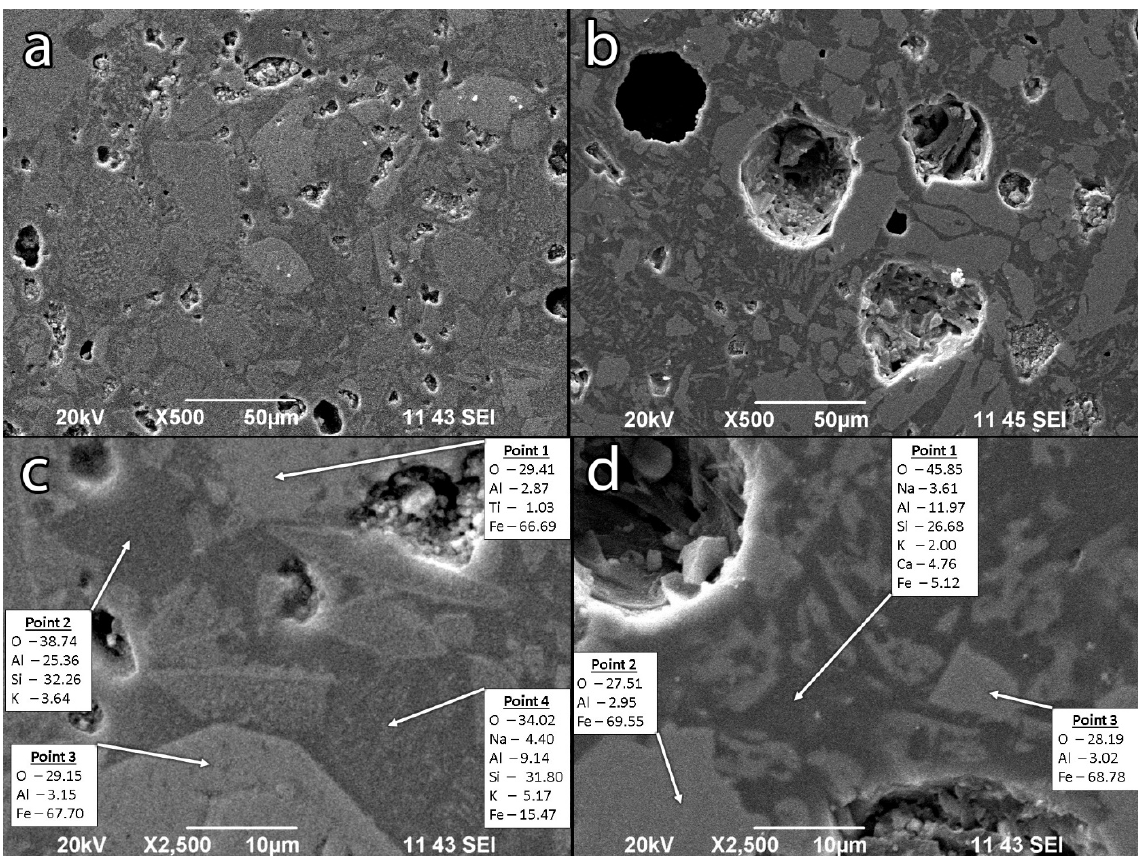
Figure 8. SEM-EDS images of geopolymer samples heat-treated to 1150 °C (( a , c ) external part of VFM4.5-1150, ( b , d ) internal part of VFM4.5-1150). In boxes: elemental EDS analysis in %.